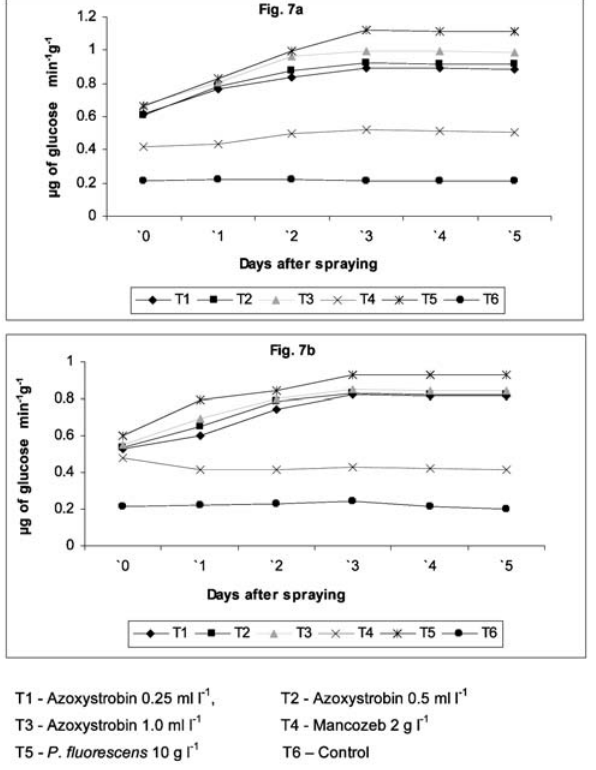
Fig. 7. Changes in chitinase activity in cucumber plants: 7a, uninoculated and treated with azoxystrobin and Pseudomonas fl uorescens ; 7b, challenge-inoculation of powdery mildew